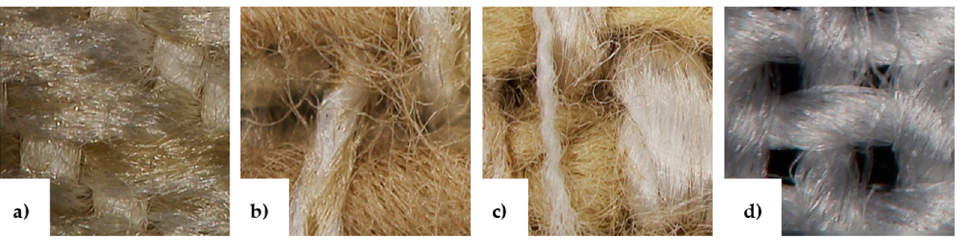
Figure 2. Optical microscopy images of untreated fabrics: ( a ) SP; ( b ) SC; ( c ) SM; ( d ) C.